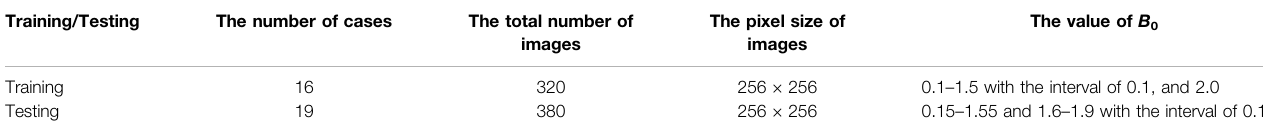
TABLE 2 | The details of the training and testing datasets.